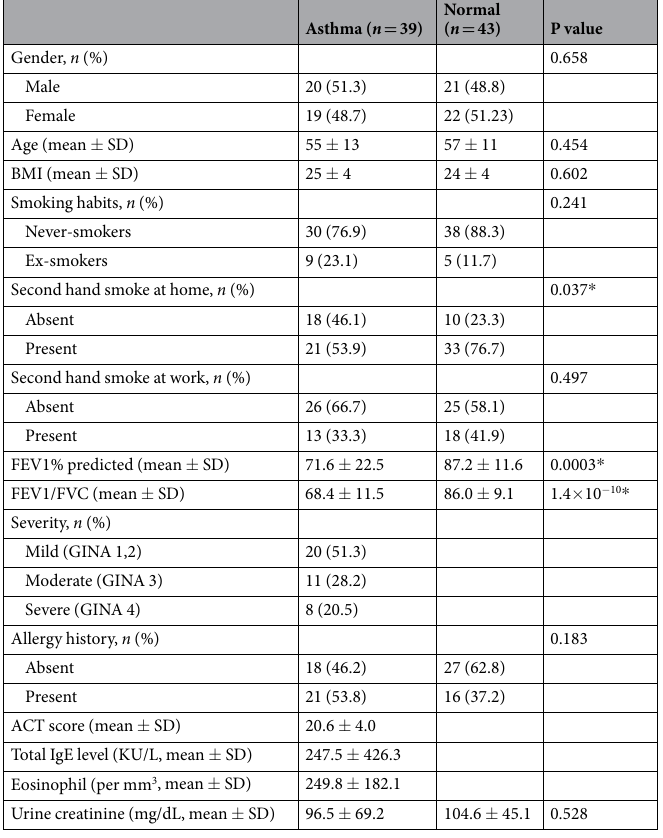
Table 1. Demographic characteristics of patients with asthma and normal controls. * Statistically significant ( P < 0.05). ACT = asthma control test; BMI = body mass index; FEV1 = forced expiratory volume; FVC = forced vital